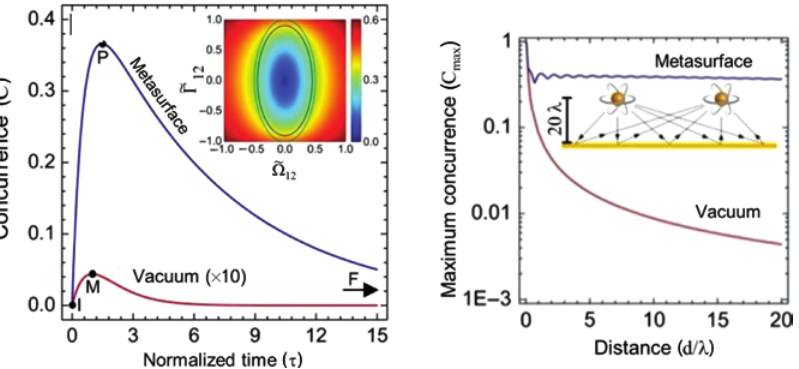
Figure 10: Metasurface-mediated quantum entanglement between two distant qubits. (Left) Plot of concurrence between two qubits as a function of time and (right) plot of maximum concurrence against the distance between the qubits. Reprinted from Ref. [24]. Copyright © 2018 by the American Chemical